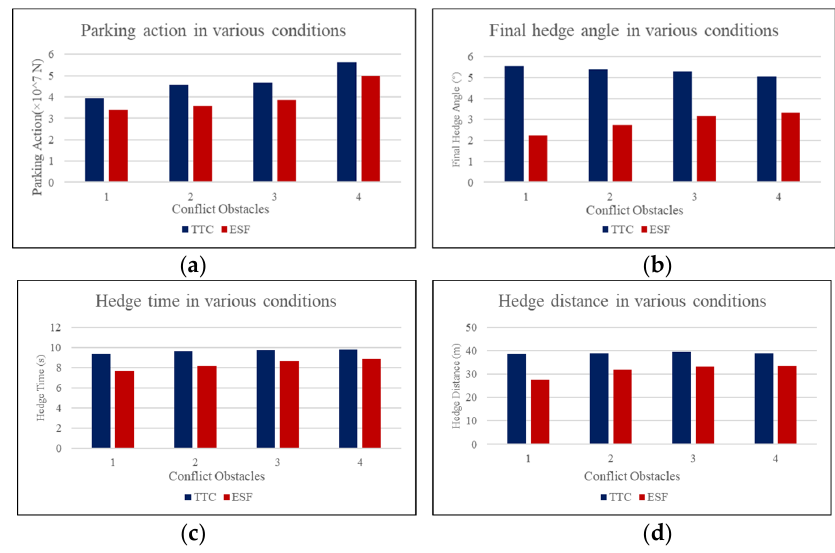
Figure 16. ( a )–( d ) are the comparison results of parking actions, final hedge angles, hedge time, and hedge distances between the TTC and ESF models with various numbers of conflict obstacles. Table 1. Comparison experiment results of emergency danger avoidance events. Conflict Final Heading Obstacles